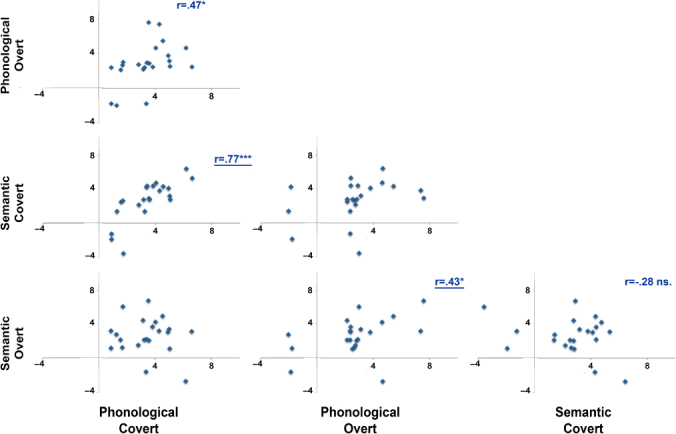
Individual LI scatterplots between conditions. Pearson correlations are displayed for relevant relationships (*p < .05, ***p < .0001, ns = non-significant). Pearson's r is underlined for those correlations that are significant after exclusion of “low” or right-lateralized participants.